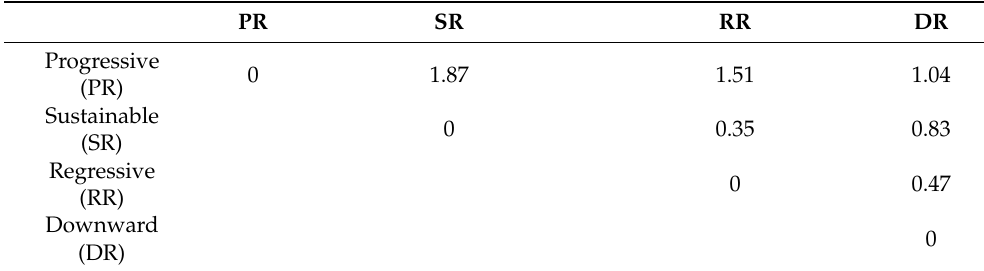
Table 4. The d coefficients of transformations between descriptive OR